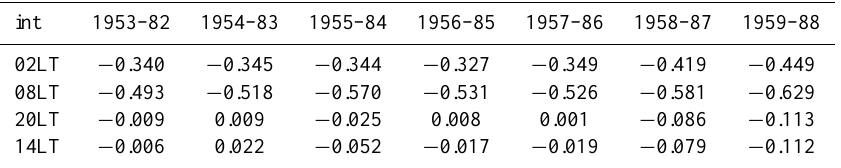
Table 6. The correlation coefficient r(δf o F2, A p ) for four LT moments for seven 30-year intervals with low values of the k(A p ) magnitude